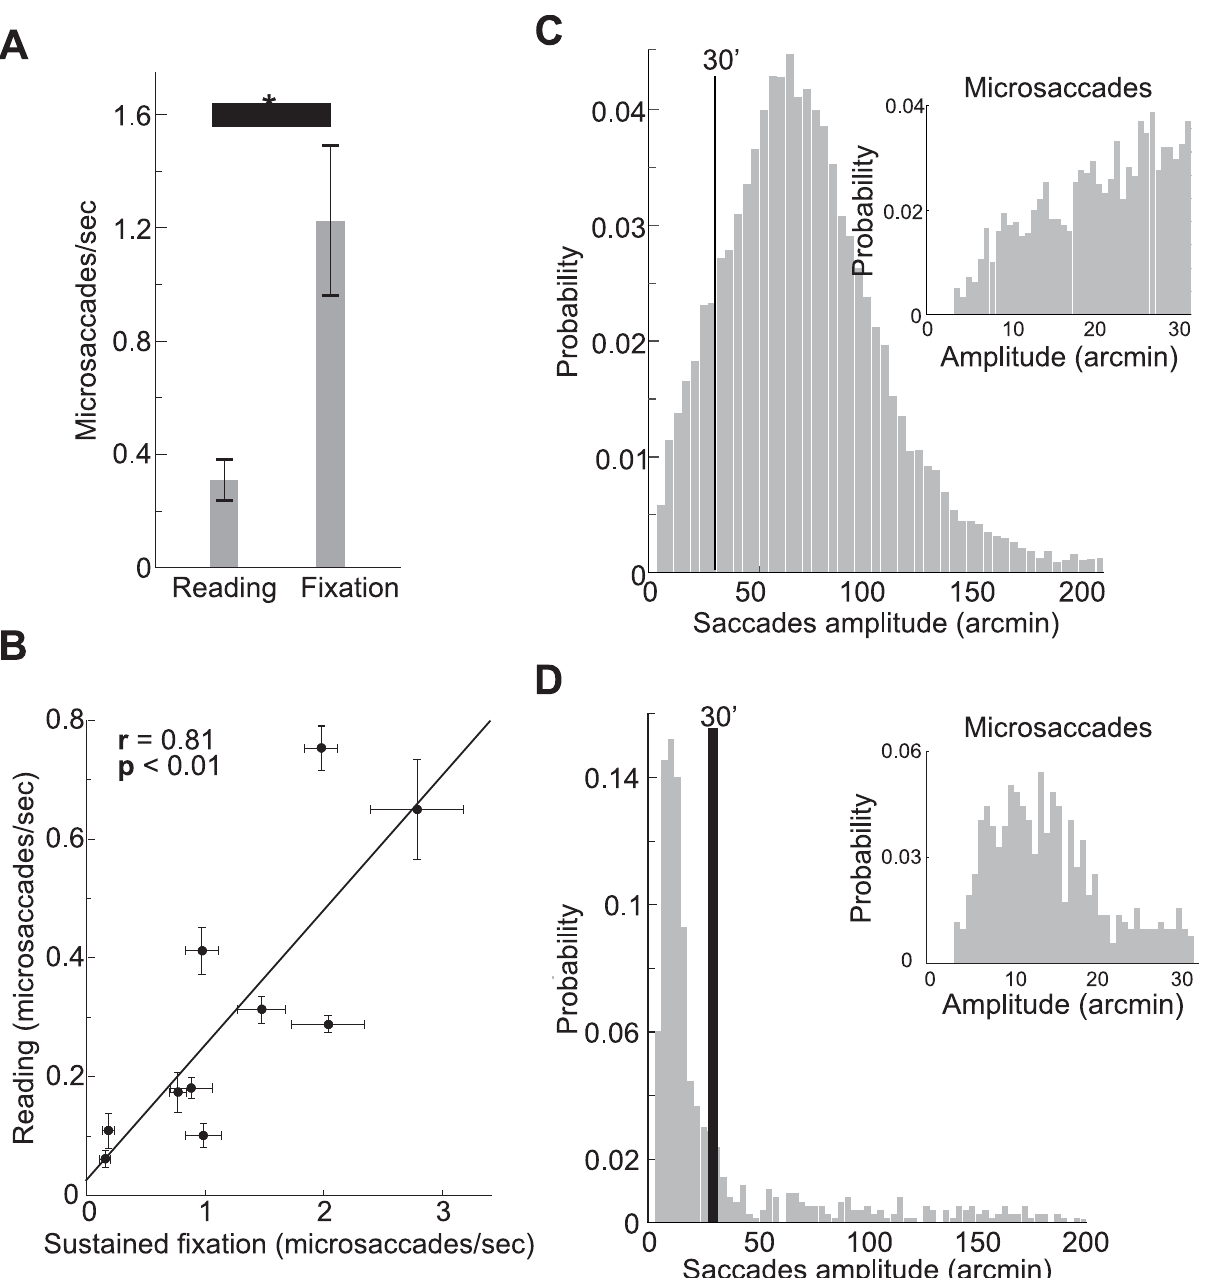
Fig 2. Microsaccades rates and amplitudes. ( A ) Rates of microsaccades duringsustainedfixation and duringreading.The asterisk marks a statistically significantdifference ( p < 0.01,two-tailedpairedt-test). ( B ) Correlation between microsaccade rates in the two conditions. Each point represents the averagerates for one subject. Error bars represent s.e.m. Probabilitydistributionof saccade amplitudes during reading ( C ) and sustainedfixation ( D ) across all the tested subjects. The vertical lines in the graphs mark the microsaccade threshold. The insets show microsaccade